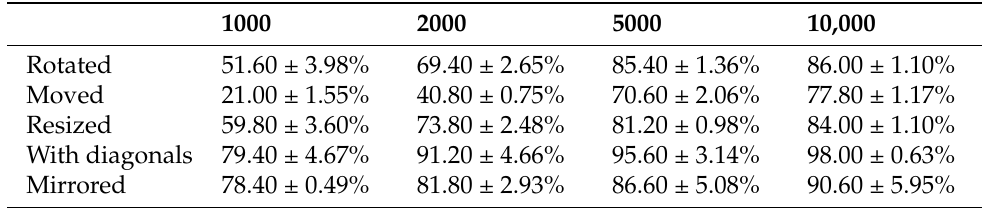
Table 12. The number of transformed objects: 8; Level of noise: 4.